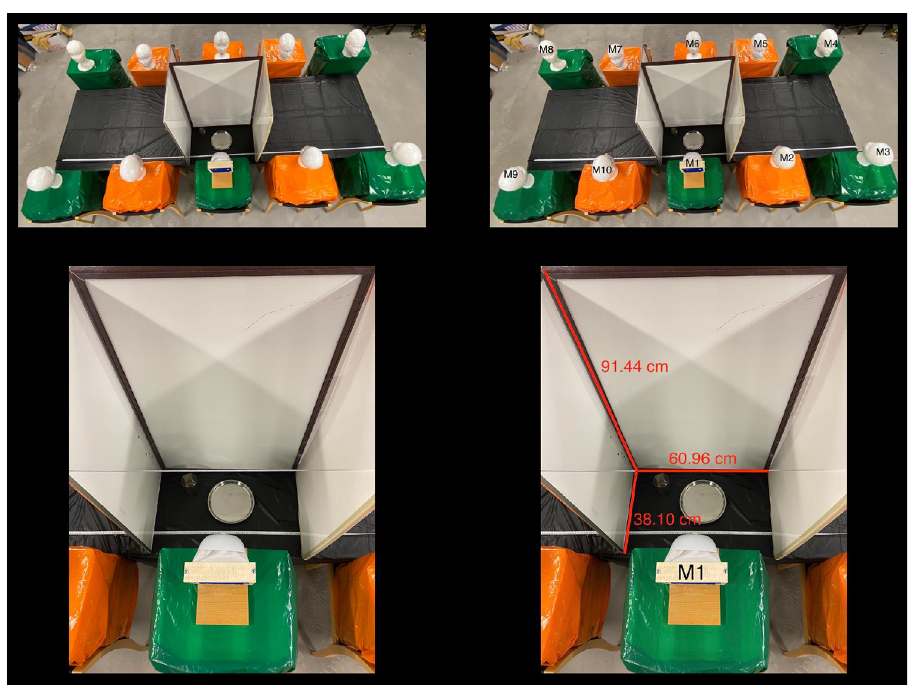
Fig 6. Measurements of normal seating positions and barrier. A white metric measuring tape with centimeter and millimeter markings is shown in each figure. (A) A bird’s eye view photo of 10 mannequins sitting in the exact same positions as experiment 3 is shown. Three whiteboards were positioned in front of the middle mannequin on the bottom of the photo. A plate and a cup were placed on the interior of the whiteboards in front of that mannequin to better simulate the eating space. In addition, plexiglass can be seen on top of the whiteboards. (B) The ten mannequins are labeled. (C) A closer picture of the barrier in front of the mannequin simulating the cough is shown as well as a plate and a cup. There is also a metric ruler in from of the mannequin on the table as a scale. (D) The height, length, and width of the barrier is shown, and the mannequin simulating the cough is labeled M1.